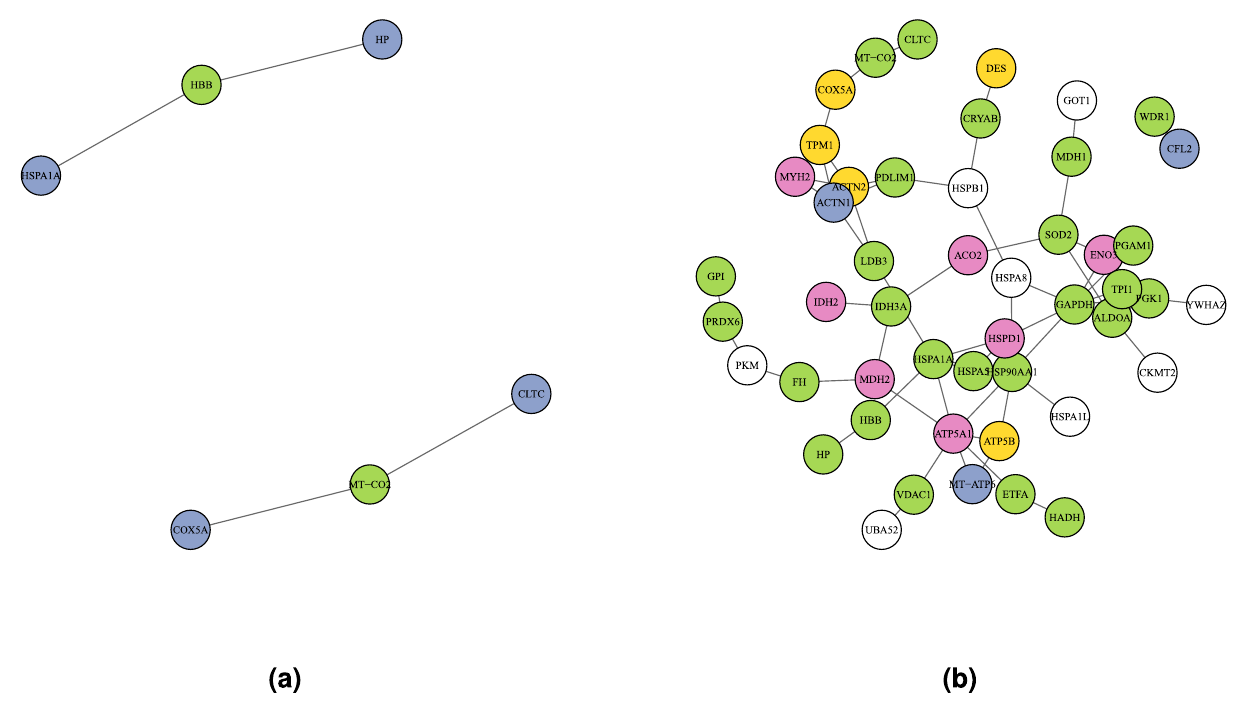
Figure 6. SSPs subnetworks. These networks represent the interactions between SSPs and their first neighbours, for both H (a) and U (b) groups, respectively. SSPs are coloured in green, SFCPs are coloured in yellow, and proteins belonging to both sets are coloured in pink. Proteins that contributed to SSPs or SFCPs degree are coloured in